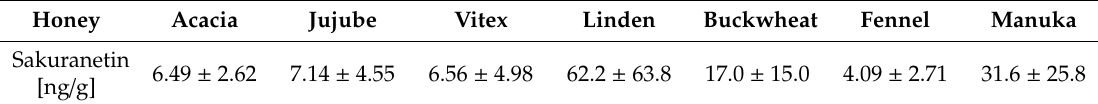
Table 2. The content of sakuranetin in honeys